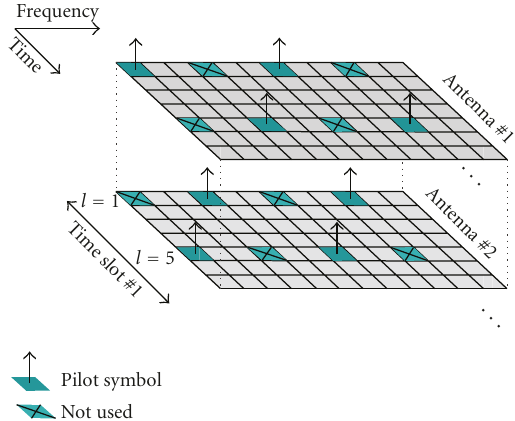
Figure 6: Example of 2D pilot arrangement with 2-antenna